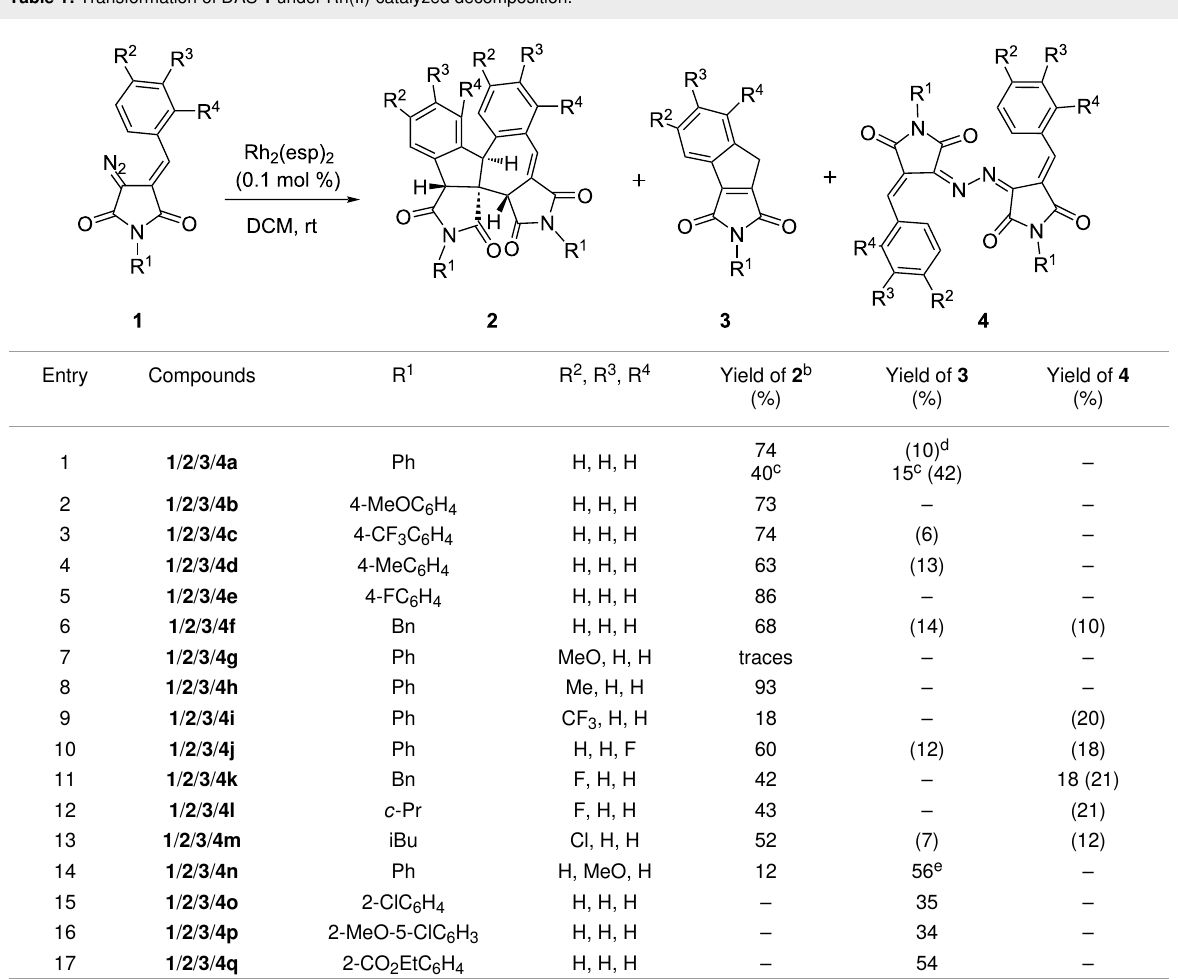
Table 1: Transformation of DAS 1 under Rh(II)-catalyzed decomposition.